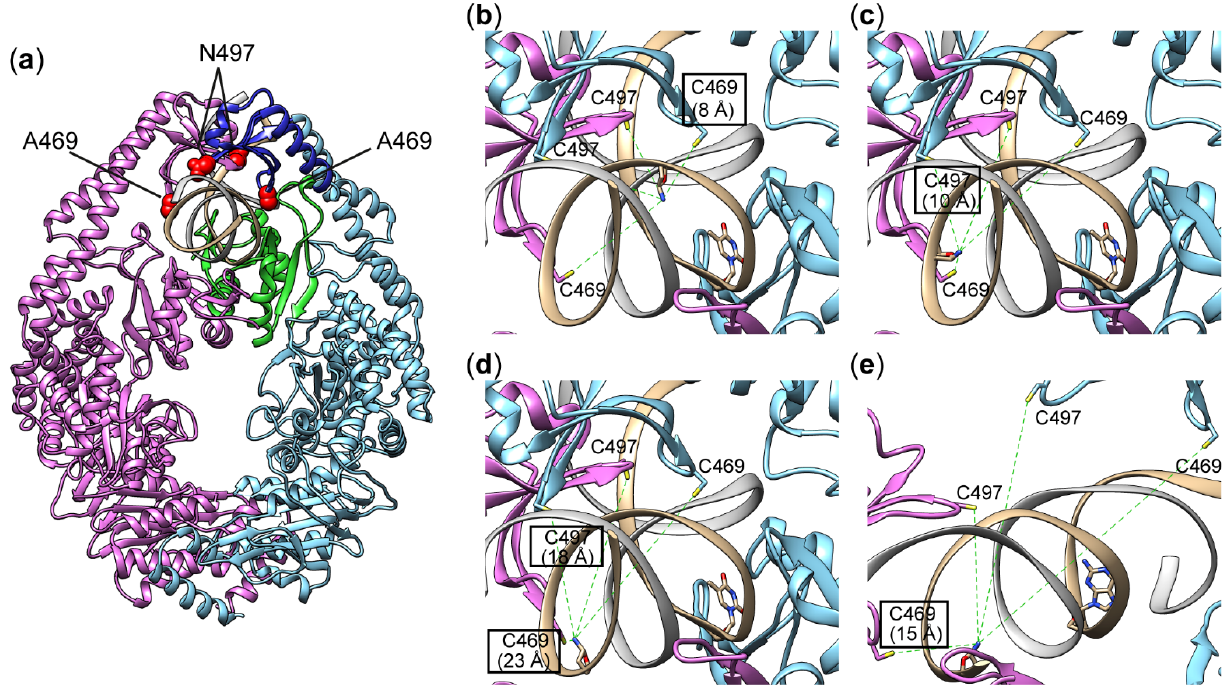
Figure 1. Complexes of MutS with DNA. An overview of the structure of MutS bound to DNA containing a mismatch ( a ). The clamp domain is highlighted in blue; the mismatch-binding domain is green, and A469 and N497 are red. The distances from the SG atom of C469 and C497 to the N atom of the heterocyclic base in the nucleotide located at the 5th ( b ), 8th ( c ) or 11th ( d ) position relative to the mismatch (see Figure 2). Panels ( b – d ) represent a detailed view of the structure of the MutS complex with a G/T-containing duplex, as determined by Cryo-EM (PDB ID 7AI6). Panel ( e ) is a fragment of a MutS complex with a canonical duplex (PDB ID 7AI5). The position of the modified base in the complex without the mismatch was determined by superposition of Cryo-EM structures with PDB IDs 7AI6 and 7AI5 (see Subsection 3.2 and Supplementary Materials). The two subunits of the protein are highlighted in blue (subunit A) and pink (subunit B), and the DNA is brown. The clamp domain is blue; the mismatch-binding domain is green, and A469 and N497 are red. Structures of native protein 7AI6 and 7AI5 have been described previously [22].